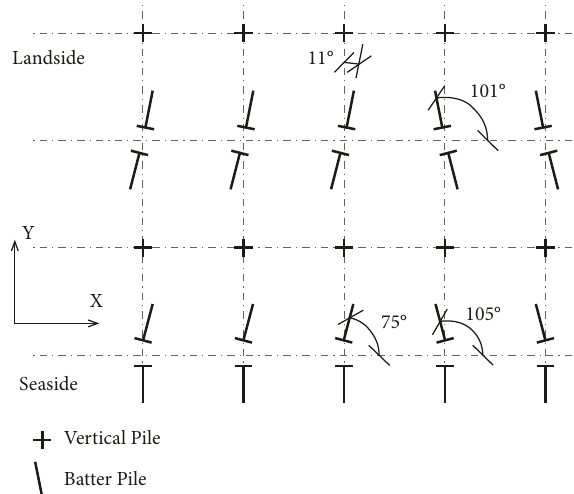
Figure 3: Coordinate system and orientation